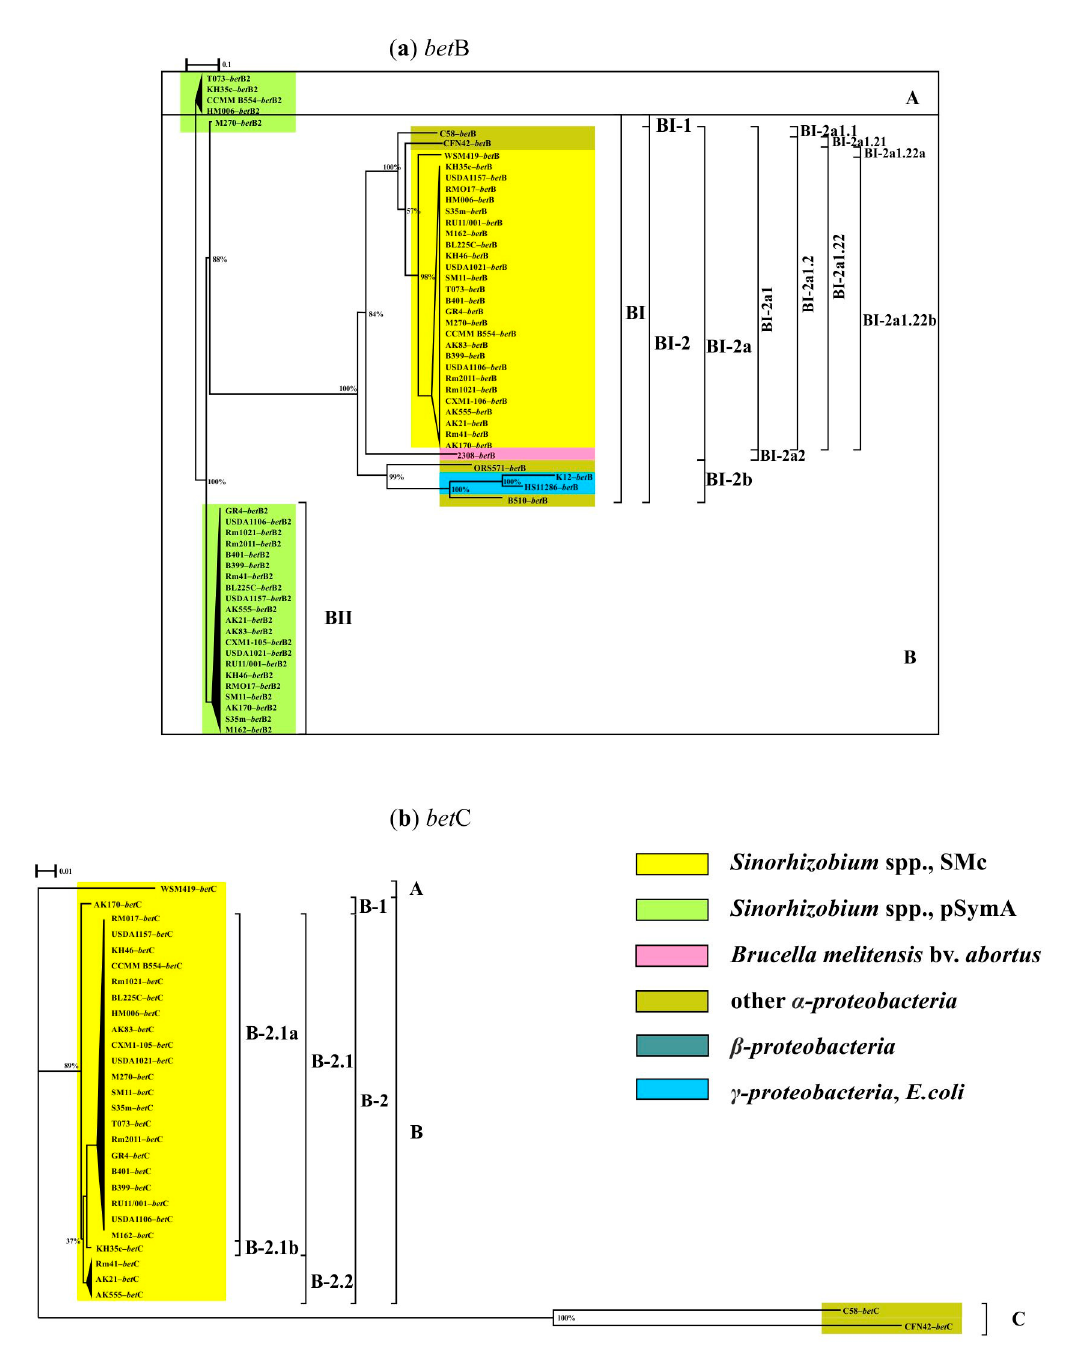
Figure 6. Phylogenetic analysis of bet B ( a ) and bet C ( b ) genes in α -, β - and γ -proteobacteria, as well as Actinobacteria . The nucleotide substitution models selected for the analysis were TVM + F + I + G4 for bet B and TVM + F + G4 for bet C sequences. The scale bars were 0.1 for bet B and 0.01 for bet C nucleotide substitutions per site.